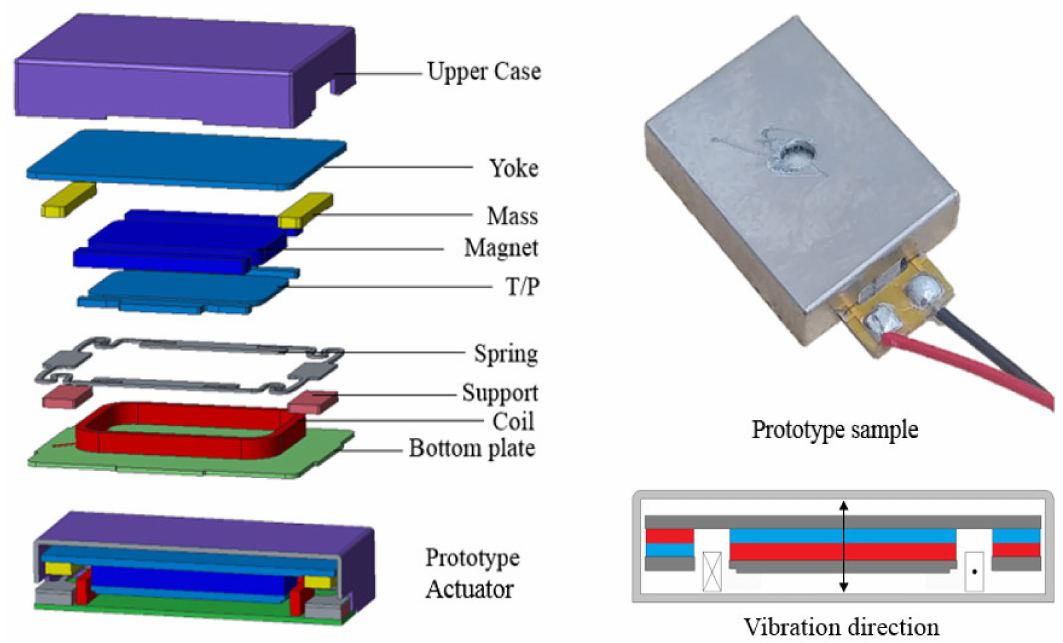
Figure 3. Prototype (3 MG) actuator